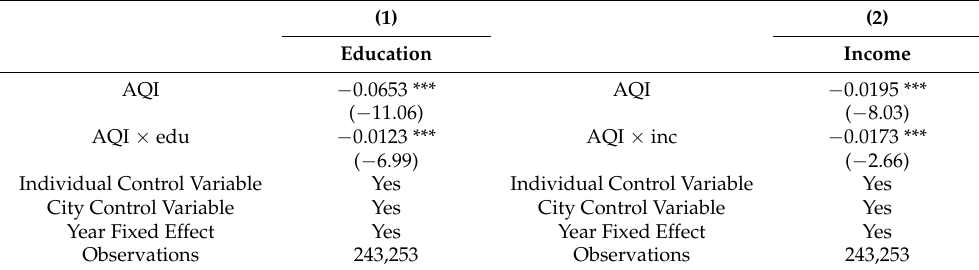
Table 3. The impact of air pollution on heterogeneous